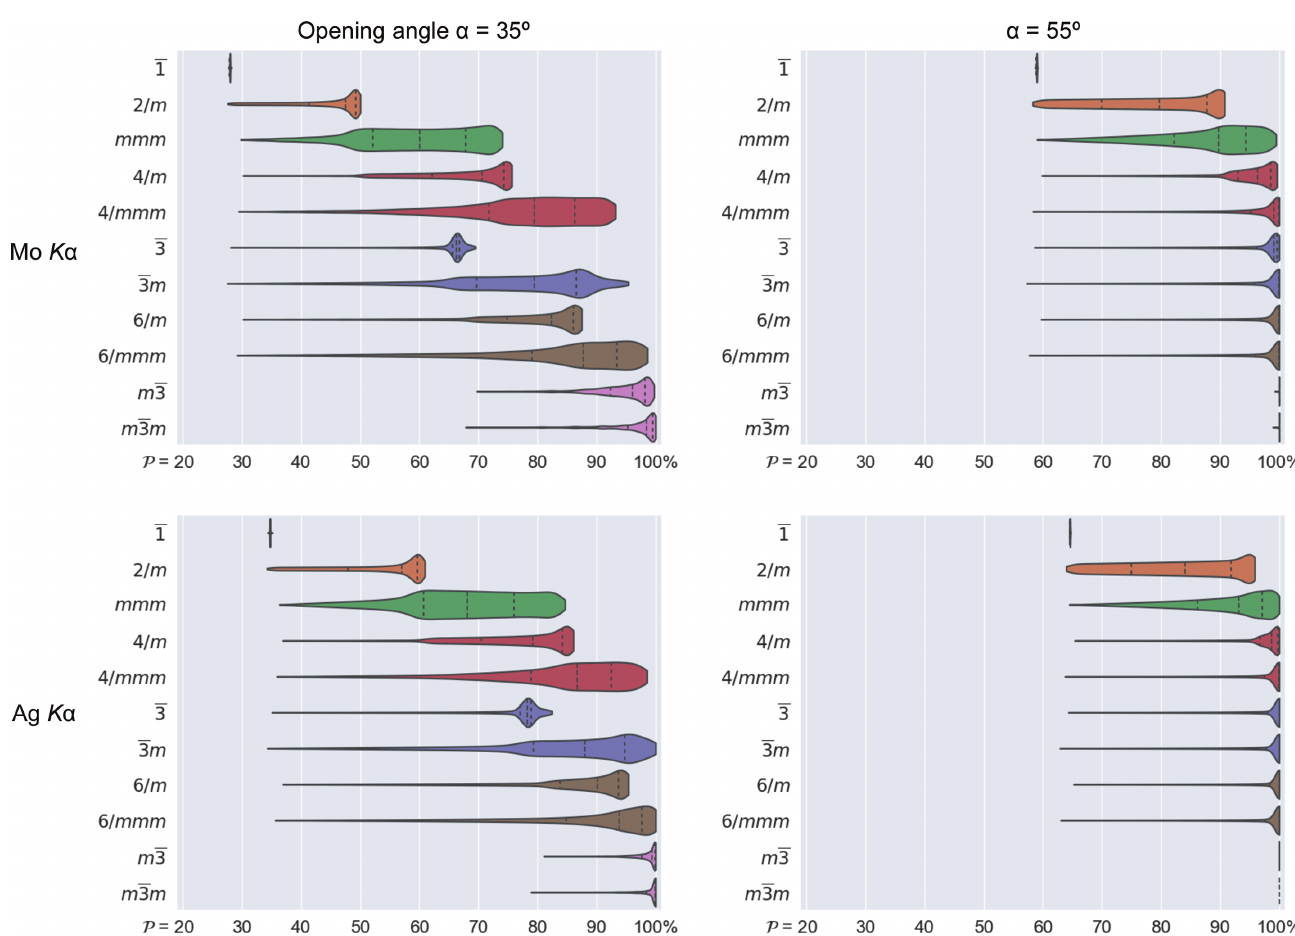
Figure 4 Violin plots representing the distribution of experiment potency for 50000 uniformly distributed crystal orientations each, presented for commonly used laboratory wavelengths and DAC opening angles. The resolution limit for all plots assumed at sin (cid:2) / (cid:5) = 0.6 A˚ (cid:3) 1 . Dashed lines represent quartiles of each distribution. Further descriptive statistics are available in Table S5.1. Opening angle and sample orientation in conjunction with sample symmetry strongly influence potency even in the cubic system, where placing the crystal on one of the {100} planes can result in an incomplete